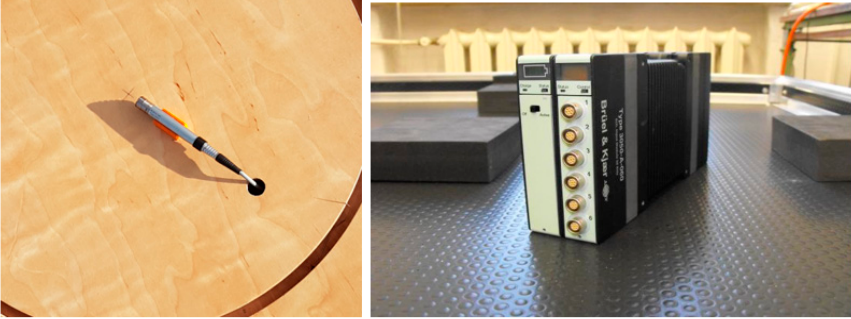
Figure 2. Microphone type 4190 digital and signal meter with LAN-XI type 3050-A-60.